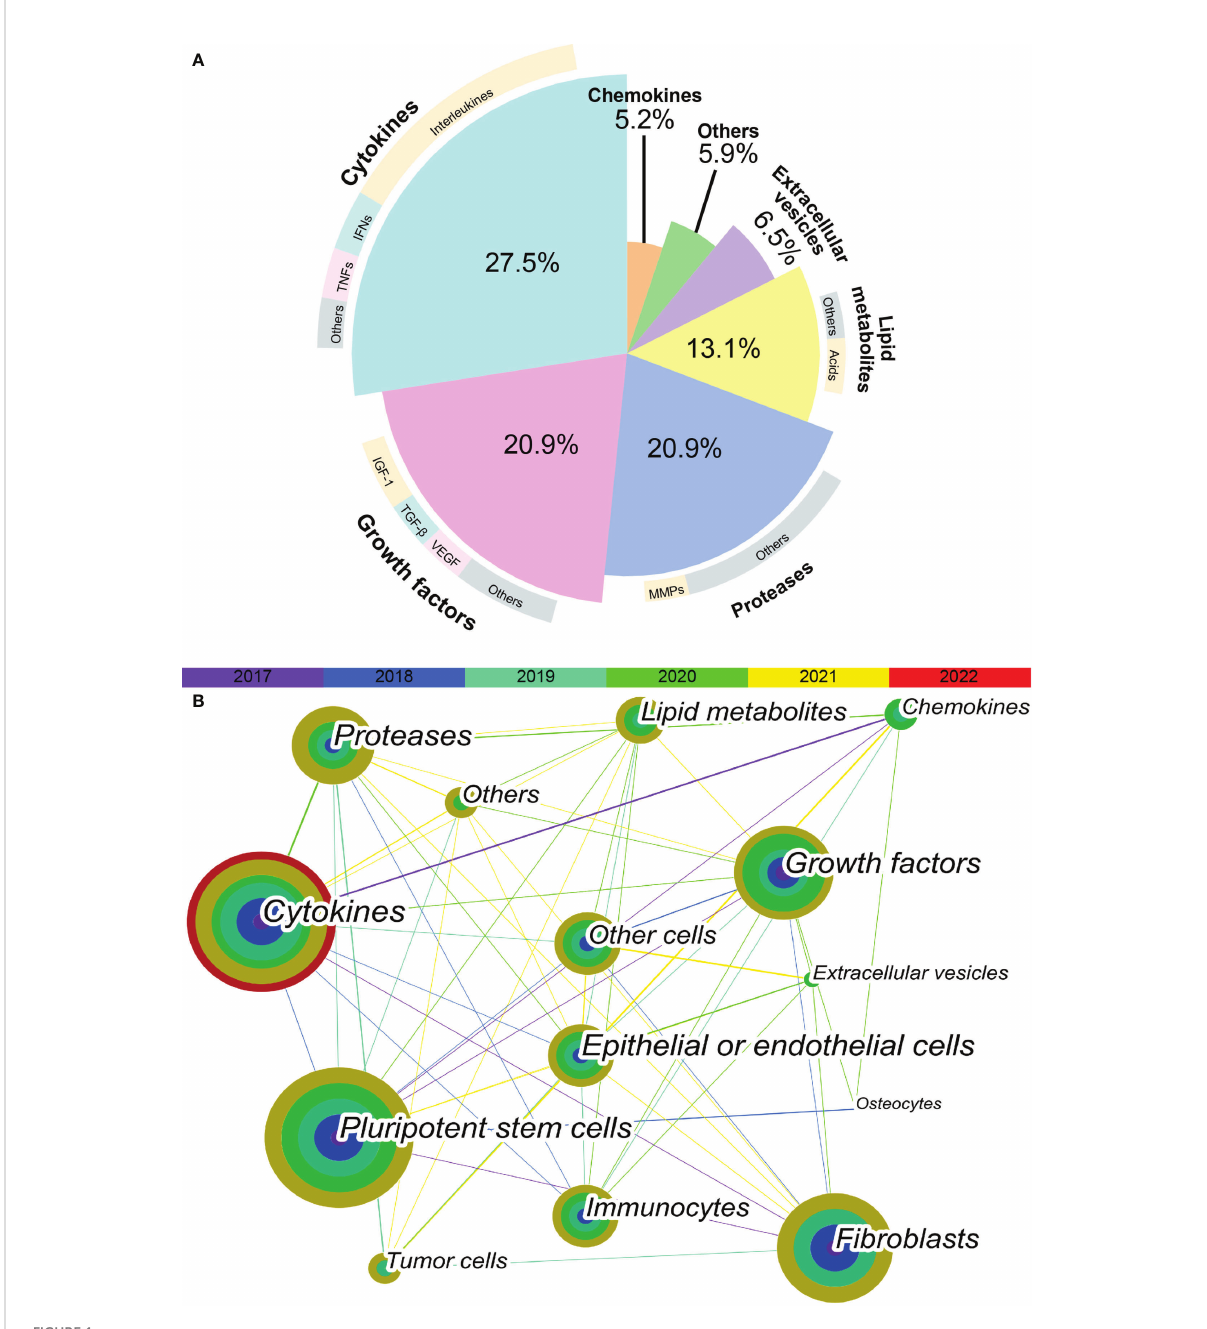
FIGURE 1 Keyword co-occurrence network visualization. (A) The proportion of different SASP factors in articles published in recent 5 years. Demonstrated as a pie plot. The inner are different types of SASP factors. The outer are most cited SASP factors of each type. (B) The keyword co-occurrence network shows the relationship between different types of SASP factors and different types of cells. Each node is a concentric circle, and the thickness of each layer of the concentric circle represents the frequency of use of this keyword in a certain year. The color of each line represents the year of the fi rst co-occurrence between the two keywords. The thickness of each line represents the frequency of co-occurrence between the two